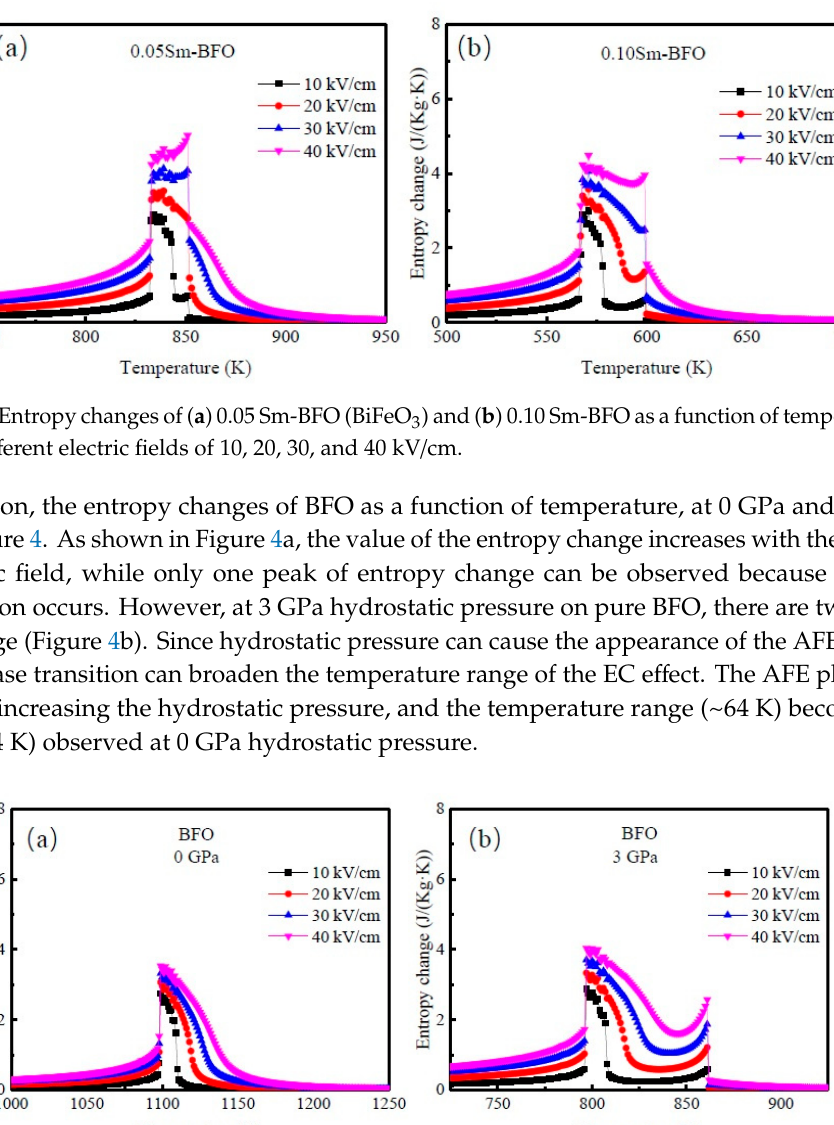
Figure 2. The total polarization with ( a ) Sm compositions and ( b ) hydrostatic pressures as a function of temperature.